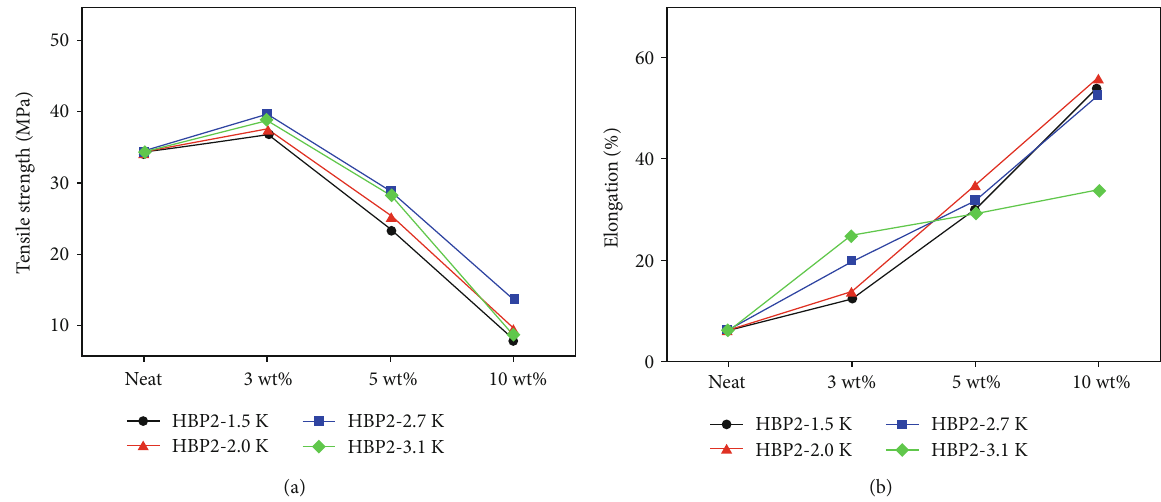
Figure 5: (a) Tensile strength and (b) elongation of epoxy/HBP2 blends with di ff erent molecular weights and HBP